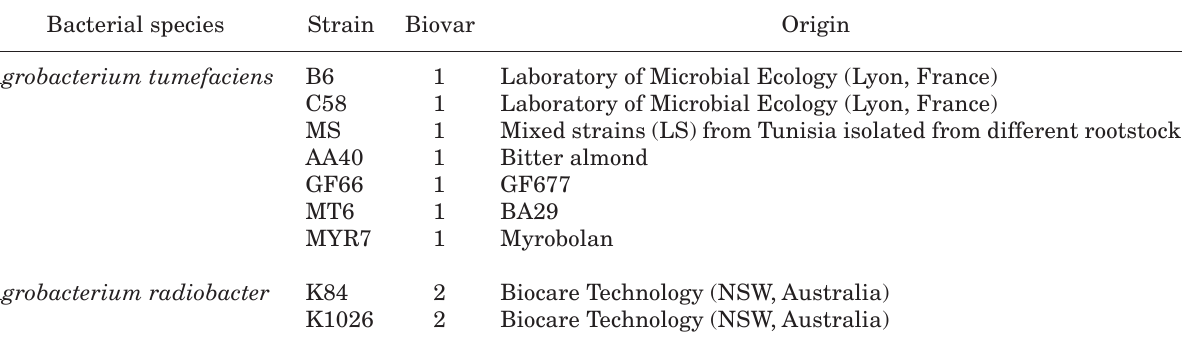
Table 1. Strains of Agrobacterium tumefaciens and A. radiobacter used in the antagonism assay. Bacterial species Strain Biovar